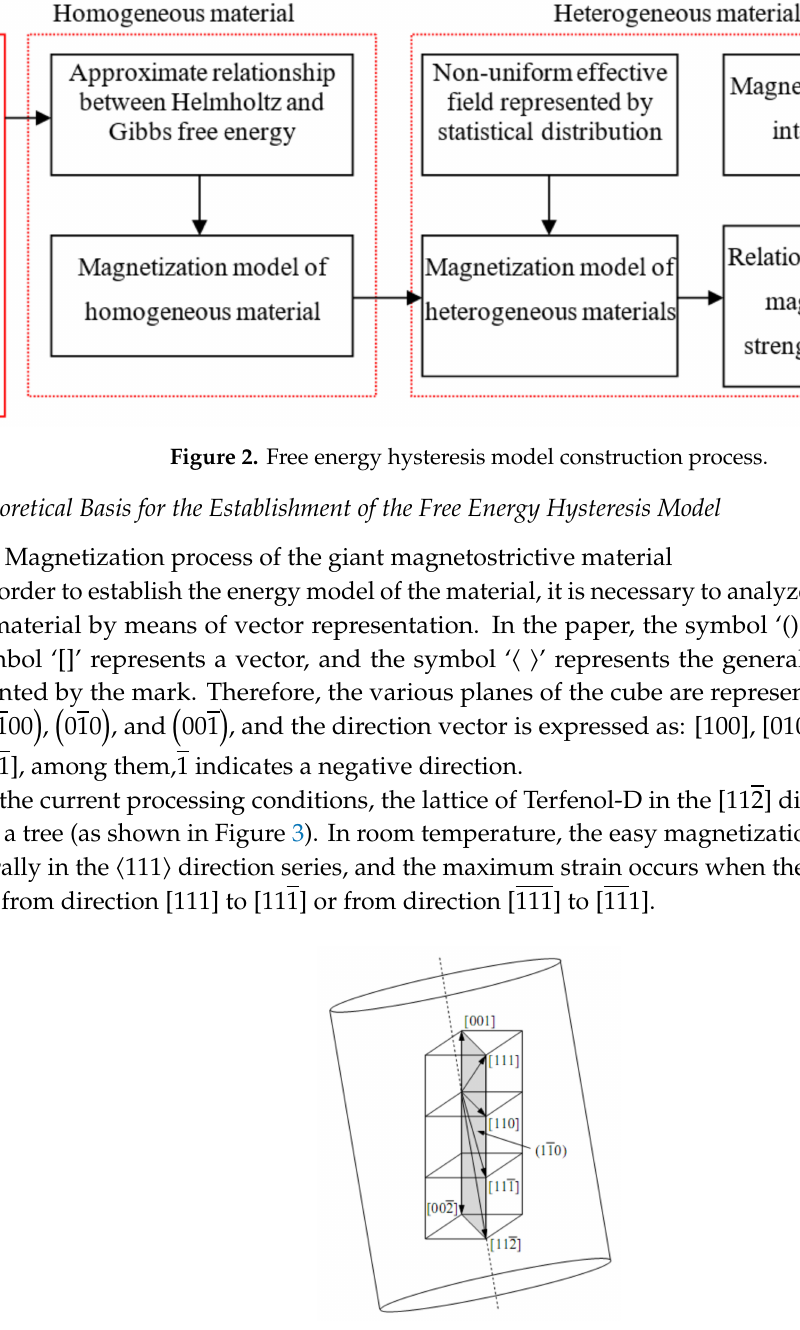
Figure 3. Lattice direction representation of